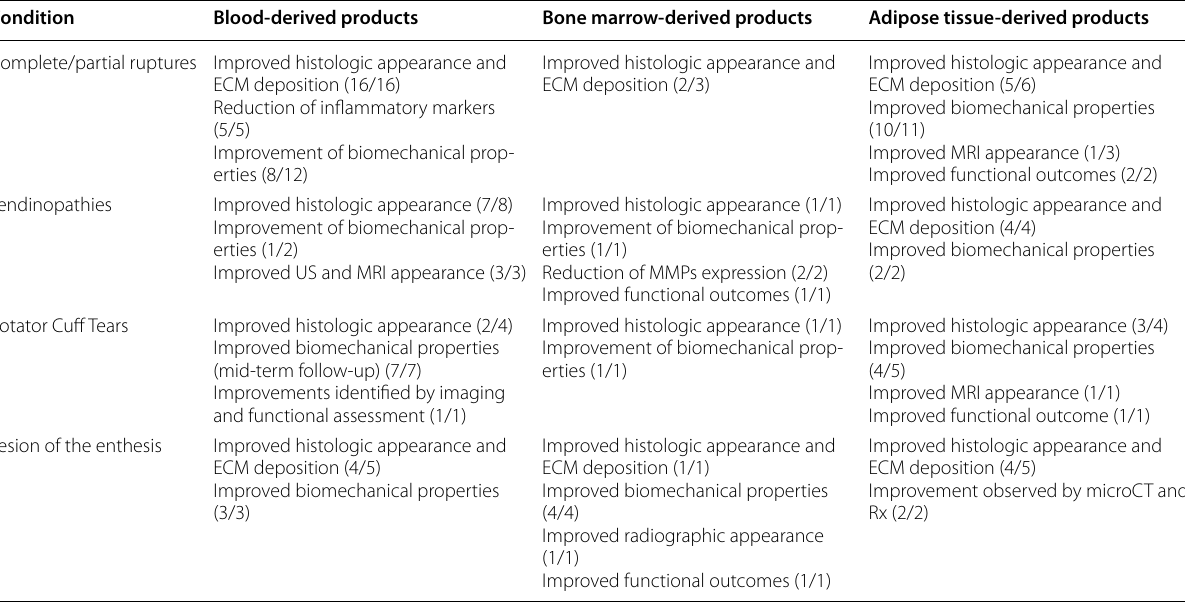
ECM extracellular matrix, GFs growth factors, mCT microcomputed tomography, Rx X-ray Number in parentheses reports the fraction of studies confirming the results among total number of studies assessing the specific outcome (studies with positive results/number of studies)